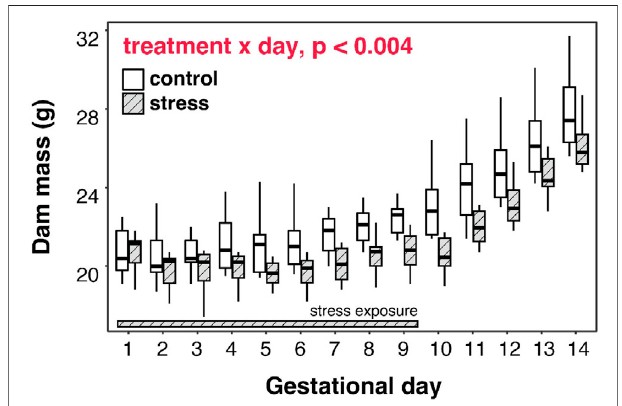
FIGURE 6 | Gestational stress inhibits mass gain by dams, and progesterone is correlated with mid-term mass in stressed dams. Pregnant mice that were exposed to chronic stress for the fi rst 9 days of gestation exhibited a different pattern of mass gain throughout gestation, compared to non-stressed mice, with a magnitude of difference increasing as pregnancy